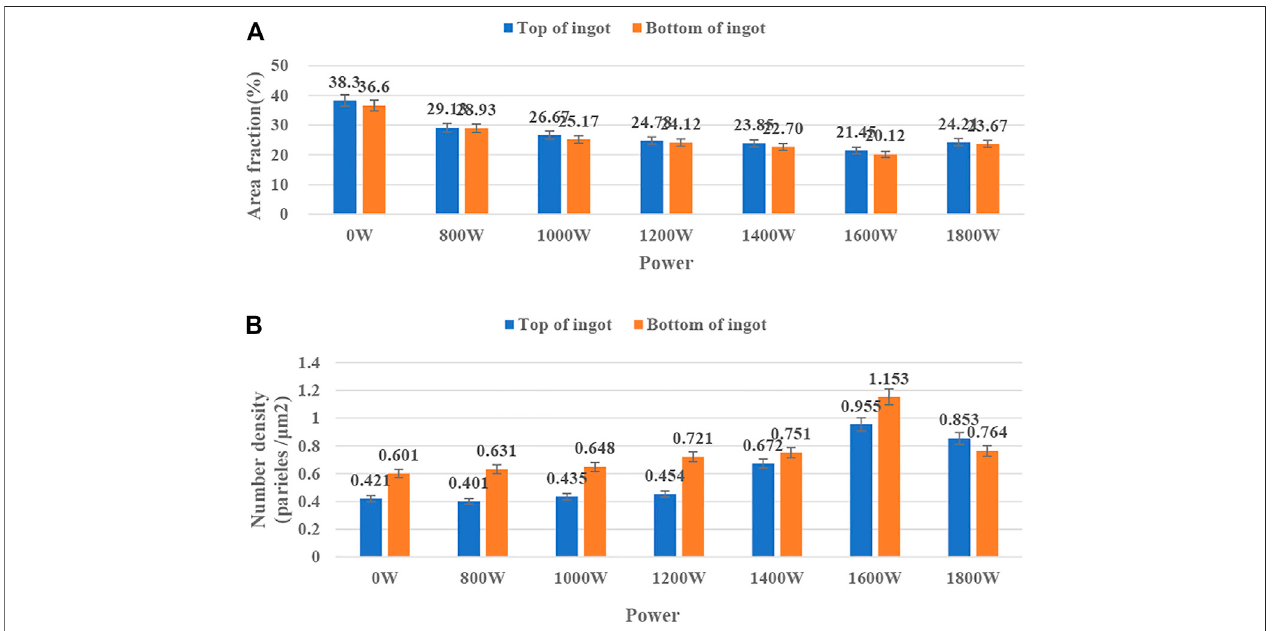
FIGURE 8 | (A) Area fraction of the precipitated phases with areas more than 20 μ m 2 and (B) number density of the precipitated particles with areas less than 20 μ m 2 at representative positions of 2195 ingots treated under different ultrasonic power.